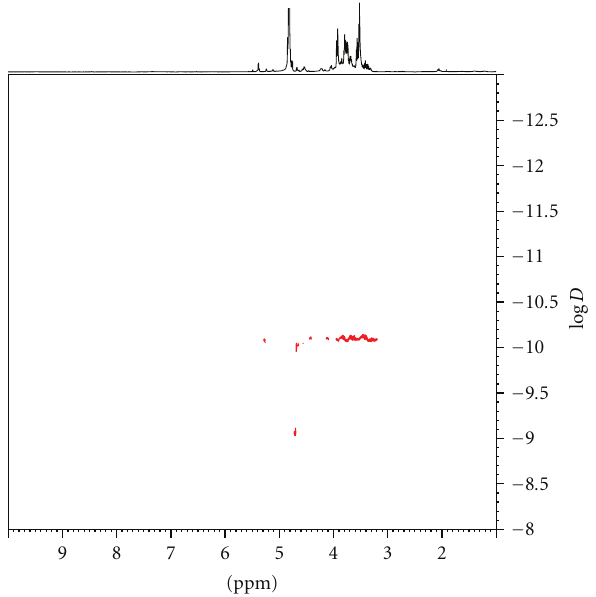
Figure 3: The 1D NMR DOSY experiment of LMG. Based on the equation, the calculated molecular weight of LMG is 3979 Da. The signal of anomeric protons merged in the HOD at 4.8 ppm and the signal, at log D = − 9 . 0, is H 2 O with molecular weight =